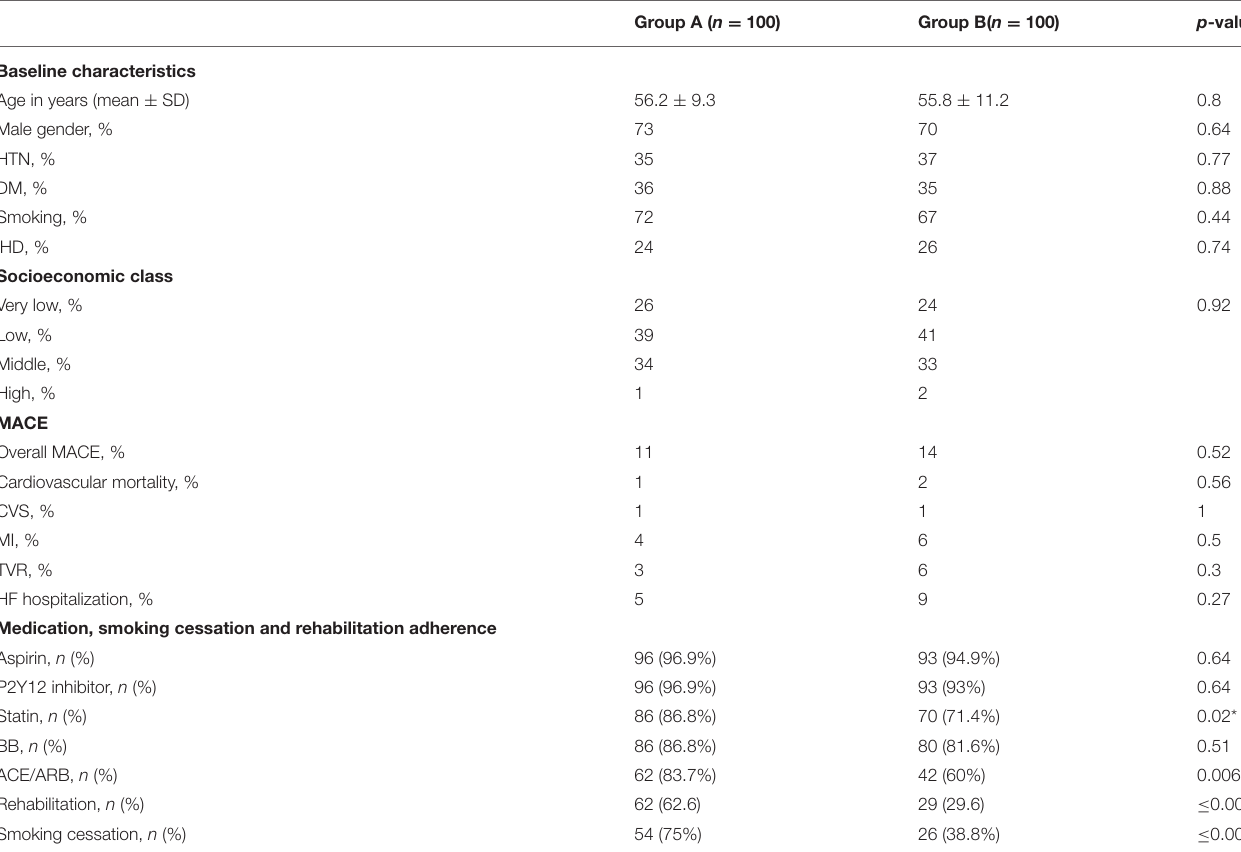
TABLE 2 | Comparison of baseline characteristics, MACE, adherence to medications, and lifestyle measures between both